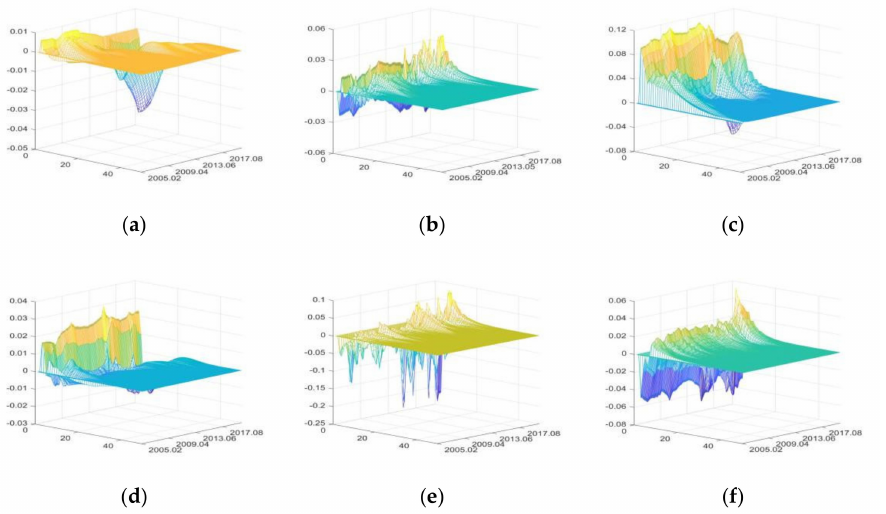
Figure 13. The three-dimensional impulse responses of FPE to positive shocks of external uncer- tainties. ( a ) Shocks of IRU. ( b ) Shocks of FU. ( c ) Shocks of SDU. ( d ) Shocks of CU. ( e ) Shocks of DE. ( f ) Shocks of PHE.